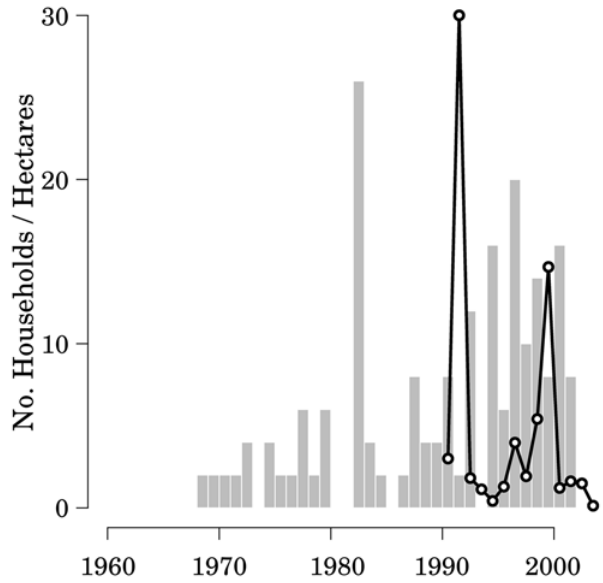
Figure 2. Number of new households (grey bars) in the four study villages (1960–2004) and the total area cleared (black line) (1990–2004). There is an apparent time lag between immigra- tion and area cleared of 9 years that is supported by the mean period between household establishment and initial land clearing (9.19 years). Statistical analysis is detailed in the text.